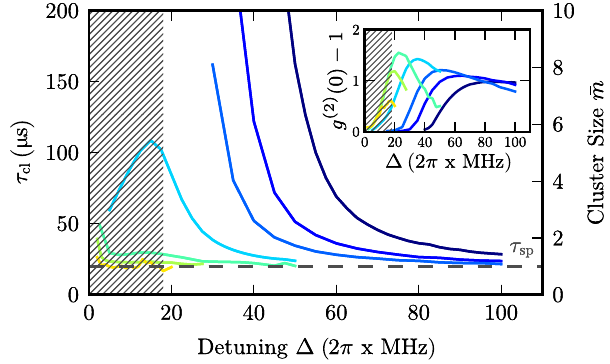
FIG. 8. Numerical results of the cluster lifetime τ bunching amplitude g ð 2 Þ ð 0 Þ − 1 (inset) using a full many-body rate-equation model with parameters estimated from the experi- ment. The color code corresponds to the same Rabi frequencies as in Fig. 3. The system contains N an interaction potential V ð r Þ ¼ C 9 =r 9 with C 9 ¼ 2 π × 2 . 1 kHz μ m 9 . Other parameters are Γ Γ 1 kHz, and σ ¼ 0 . 06 μ m. The gray shaded area corre- n ¼ sponds to the area where the decoherence rate γ approximation anymore (see Appendix